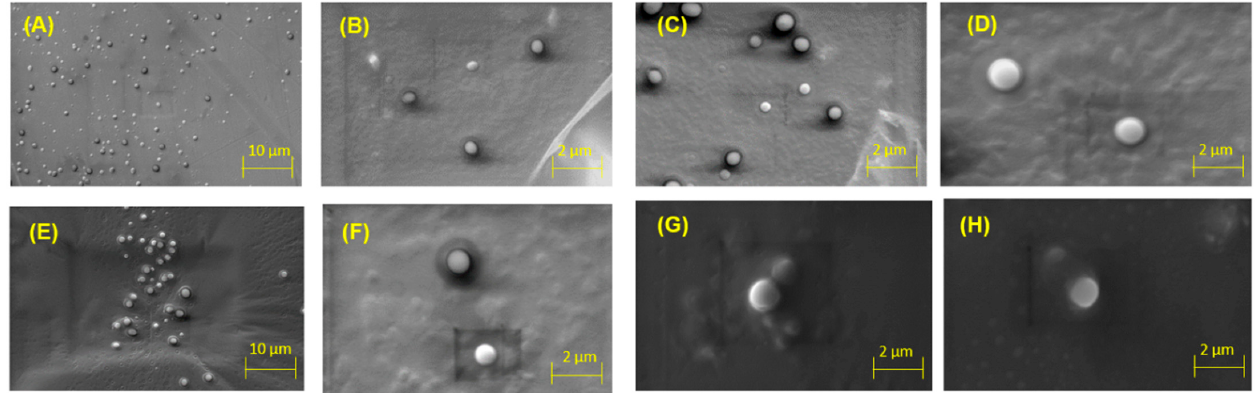
Figure 3. Scanning electron microscope (SEM) images of OEO nanoliposomes at different magnifications (top line): 1.00 K ( A ), 2.00 K ( B ), 4.00 K ( C ) and 6.00 K ( D ), and control nanoliposomes (bottom line): 1.00 K ( E ), 2.00 K ( F ), 4.00 K ( G ) and 6.00 K ( H ).